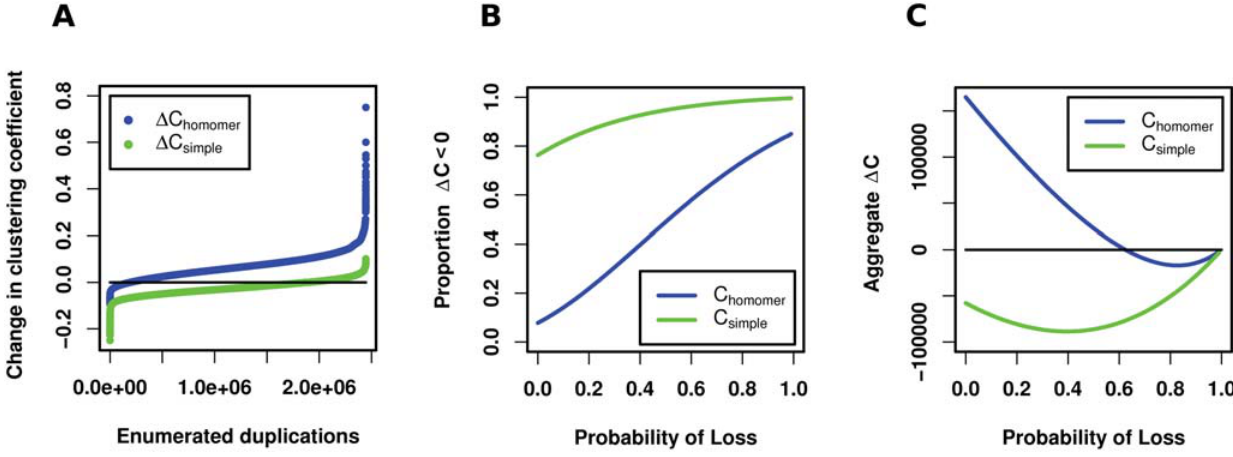
Figure 8. The effect of gene duplication on the clustering coefficient. Every connected network containing three to nine nodes was enumerated producing 273,191 networks containing 2,445,434 nodes. (A) Changes to the clustering coefficient resulting from simple duplication and homomeric duplication. Each of the 2,445,434 nodes was duplicated twice, once as self-interacting (homomeric) and once as non-self-interacting (simple). Shown is the change in clustering coefficient for each duplication, ordered by magnitude. The enumerated networks serve as possible subnetworks of larger protein interaction networks. The magnitude of the vertical axis is determined by the size of the network, but the shape of the curves around zero remains unchanged. (B) The severe effect subfunctionalization has on the clustering coefficient. The vertical axis represents the portion of the 2,445,434 gene duplications in the enumerated networks which result in a decrease in the clustering coefficient. Probability of Loss is the probability the gene duplicate (progeny) loses each of its interactions due to subfunctionalization. Even without losses suffered due to subfunctionalization, simple duplications reduce the clustering coefficient in over 76% of examined duplications. By contrast, clustering coefficients produced via homomericduplication are far more likely to increase even in theface of interaction losses caused by subfunctionalization. (C) Theeffect of subfunctionalization on aggregate D C . The change in clustering coefficient aggregated for all 2,445,434 duplications at each loss probability. While aggregate D C of simple duplication is below zero for all loss probabilities, homomeric duplications remain above zero until the Probability of Loss < 0.62.